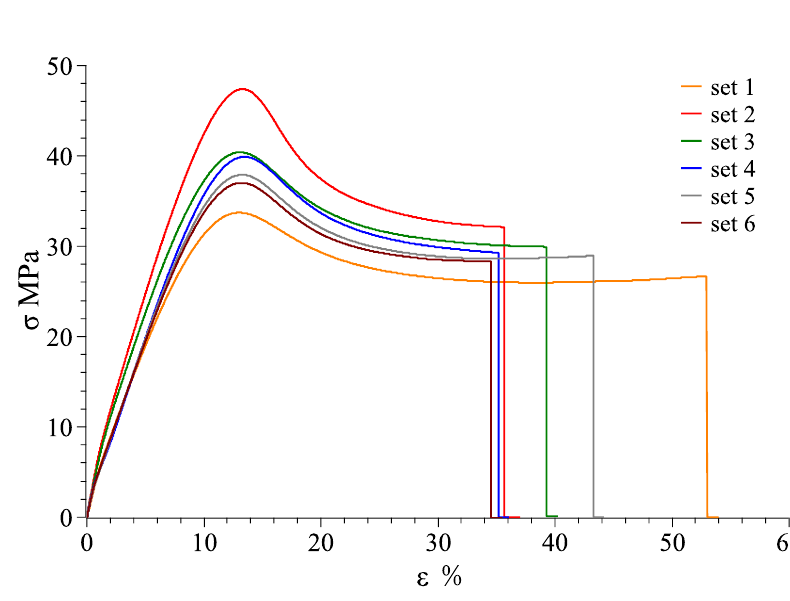
Figure A1. D8510, D8520 stress–strain curve for the X-axis (6 specimens).